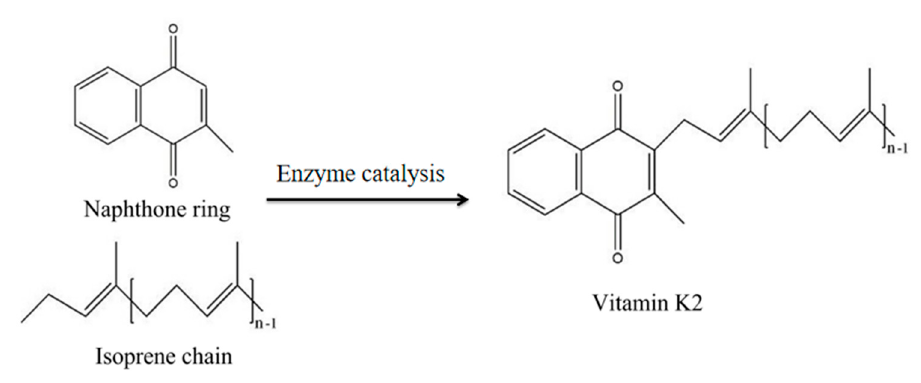
Figure 7. Structure and composition of vitamin K 2 . n-1: the number of isoprene units